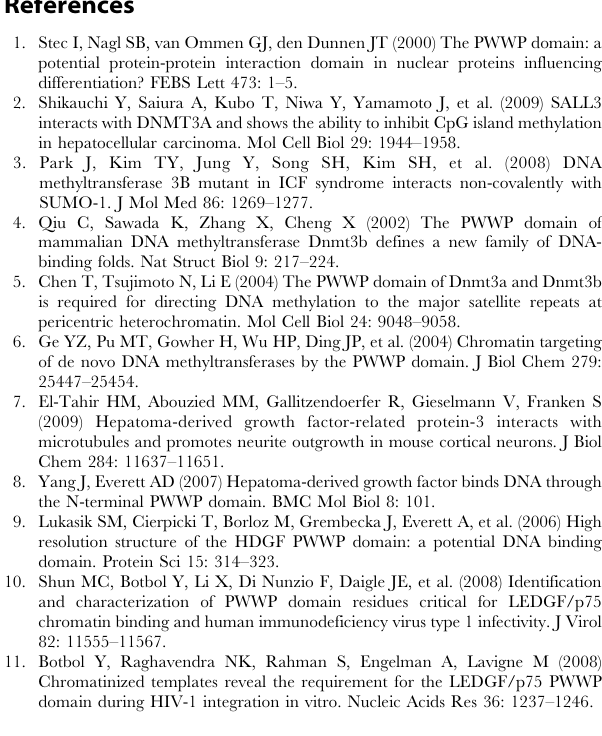
Figure S1 Electron density maps for the ligands identi- fied in our complex structures and reported in this paper. (A) The omit density map for the H3K36me3 peptide in the BRPF1-H3K36me3 complex at 3 s contour. (B) The omit density map for the H3K79me3 peptide in HDGF2 + H3K79me3 at 3 s contour. (C) The omit density map for the H4K20me3 peptide in HDGF2 + H4K20me3 at 2 s contour. (D) the 2Fo-Fc density map for the bis-tris molecule in the DNMT3A-bis-tris structure. (E) the 2Fo-Fc density map for the bis-tris molecule in the DNMT3B-bis- tris structure.